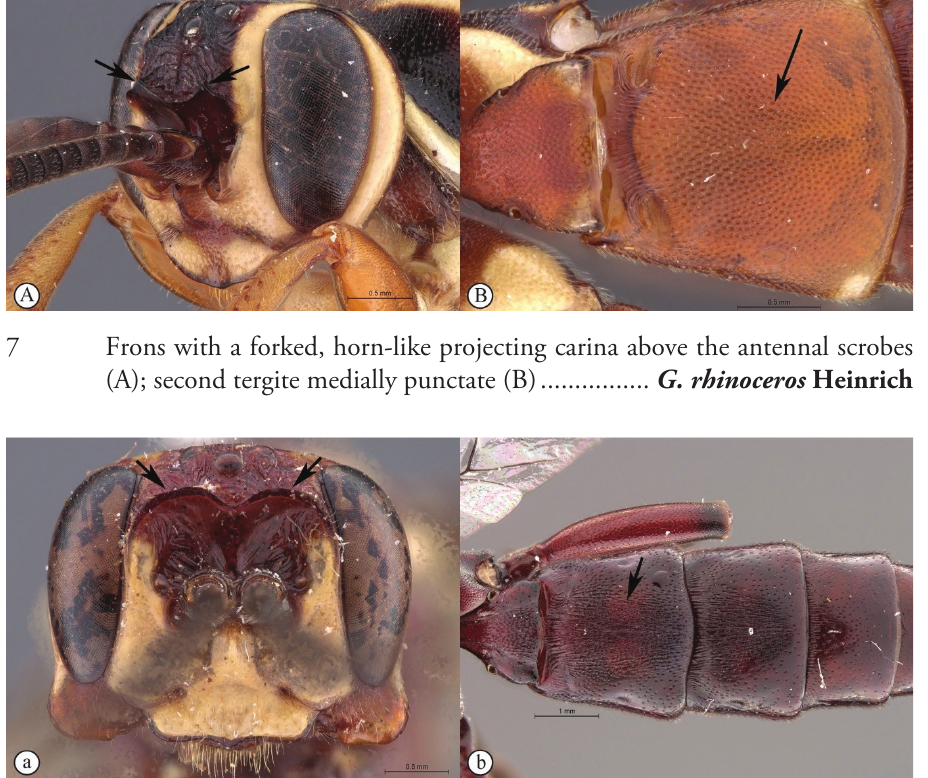
– Frons with a broad to acute cordate lamella above the antennal scrobes (a); sec- ond tergite medially longitudinally strigose (metasoma lacking in ♀ allotype of G. varianum , but ♂ holotype tergite is longitudinally strigose) (b) ........... 8